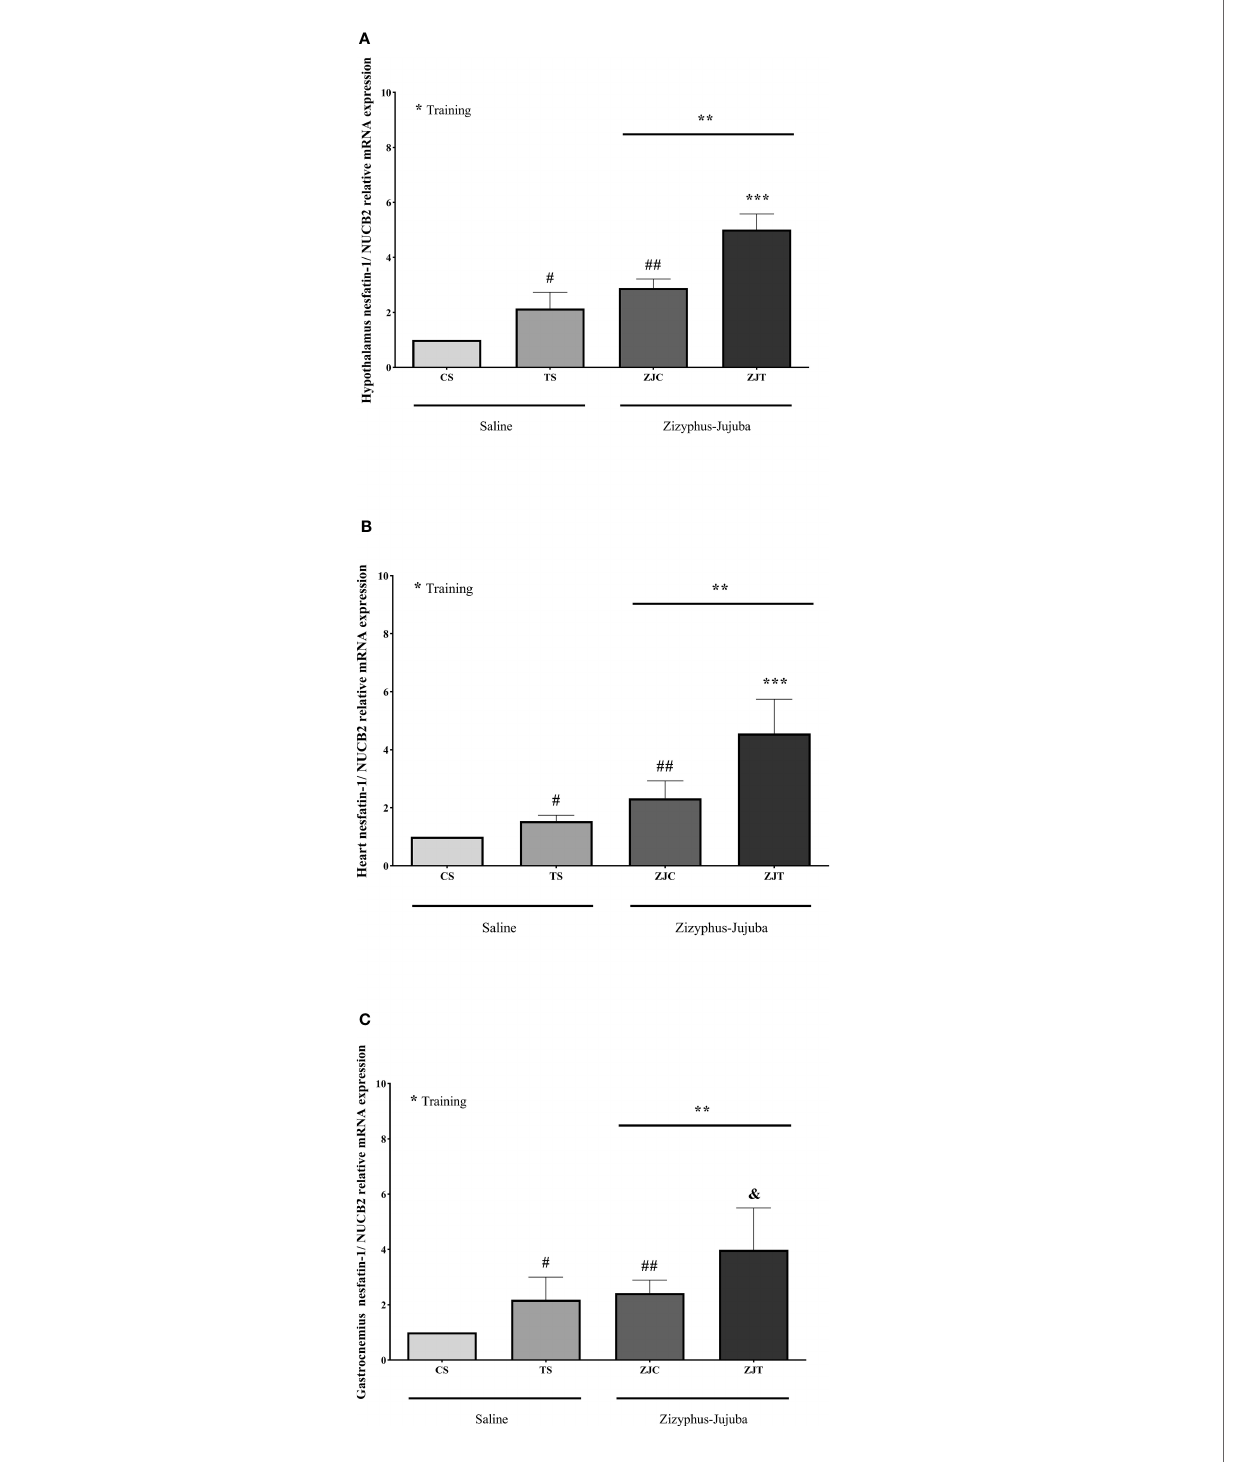
FIGURE 2 | Hypothalamus (A) , heart (B) and gastrocnemius (C) nesfatin-1/NUCB2 gene expression than b actin in Saline-Control (SC), Saline-High Intensity Training (ST), Ziziphus jujuba -Control (ZJC), and Ziziphus jujuba -High Intensity Training (ZJT) groups. Data were expressed mean ± SD, P value set at < 0.05, and 7 rats per each group. * Training main effect (P=0.001 for hypothalamus and heart, P=0.002 for gastrocnemius), ** Ziziphus jujuba main effect (P=0.001 for hypothalamus, heart and gastrocnemius), *** Training and Ziziphus jujuba interaction (P=0.039 and P=0.035 for hypothalamus and gastrocnemius respectively), # TS than CS (P=0.001 and P=0.048 for hypothalamus and gastrocnemius respectively), ## ZJC than CS (P=0.001, P=0.02 and P=0.019 for hypothalamus, heart and gastrocnemius respectively), & ZJT than TS (P=0.001 for hypothalamus and heart, P=0.004 for